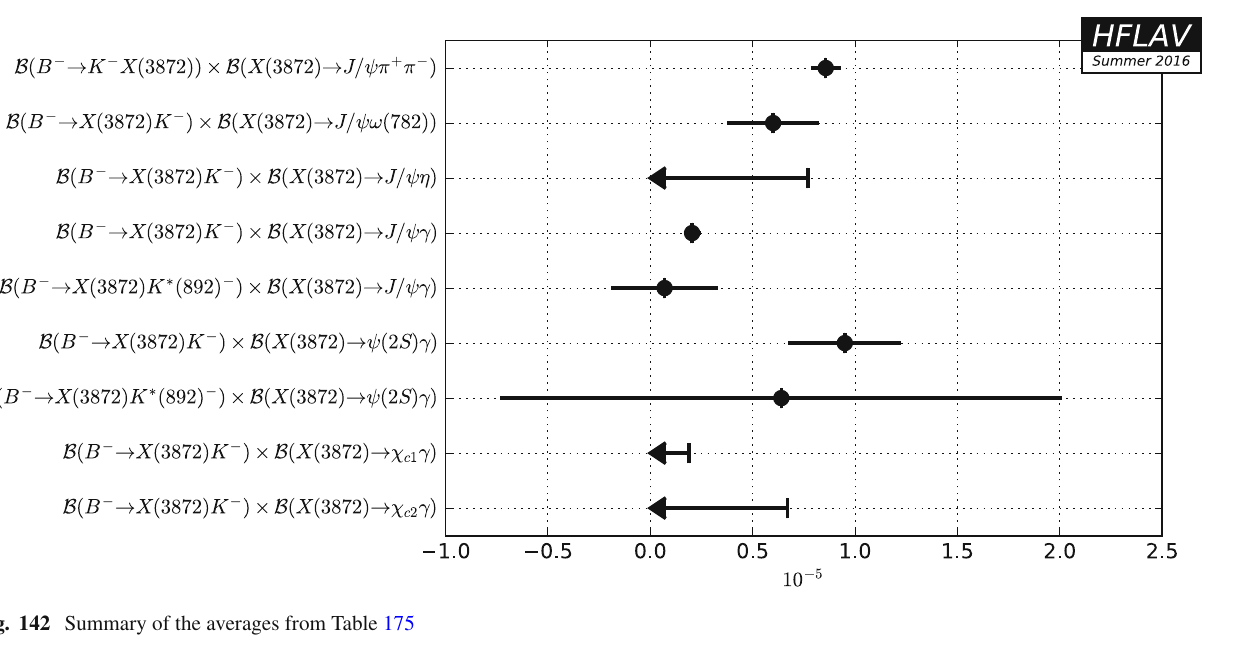
Fig. 142 Summary of the averages from Table